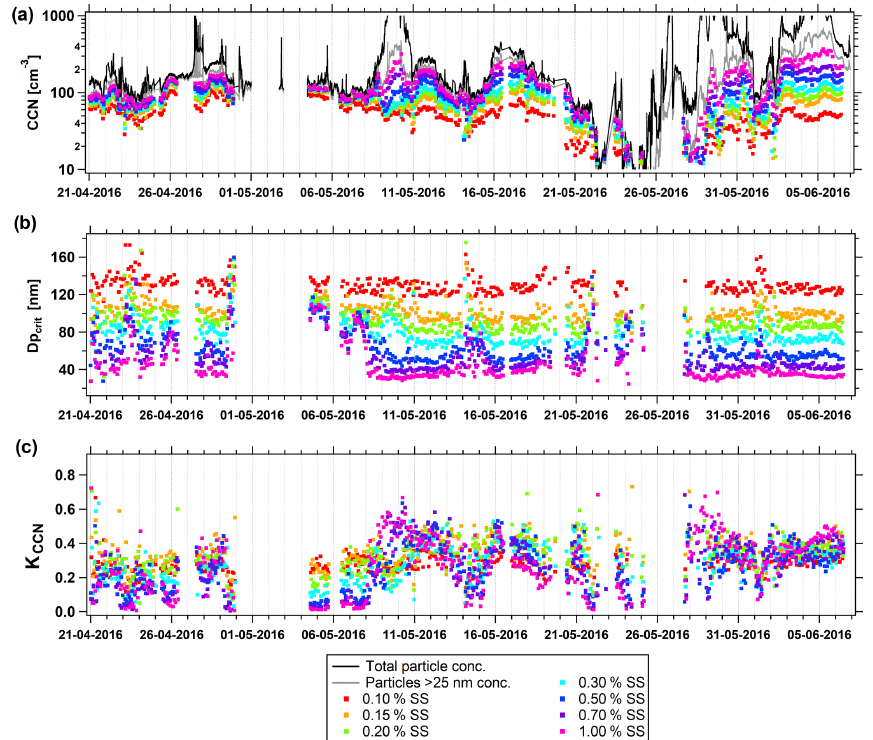
Figure 5. CCN properties at various SSs during the spring measurement period. (a) Particle and CCN number concentration, (b) critical activation diameter (Dp crit ), and (c) κ CCN value. Black line: total particle number concentration inferred from SMPS measurements ( N tot ), gray line: number concentration of particles > 25nm ( N 25 ), colored symbols: CCN measurements at 0.1%–1.0% SS. Table 2. Statistics of CCN measurements for the spring field study. The uncertainty values stated with CCN mean, CCN median, Dp crit mean, and Dp crit median are the respective statistics of the associated uncertainty found in the fitting procedure. The values of SD are the standard deviations of the parameter distributions over the temporal evolution of the study. The asterisk ( ∗ ) signifies a significant difference between spring and summer field studies (Wilcoxon rank sum test, p < 0 . 05). CCN measurements for the spring field study were obtained from 20 April to 6